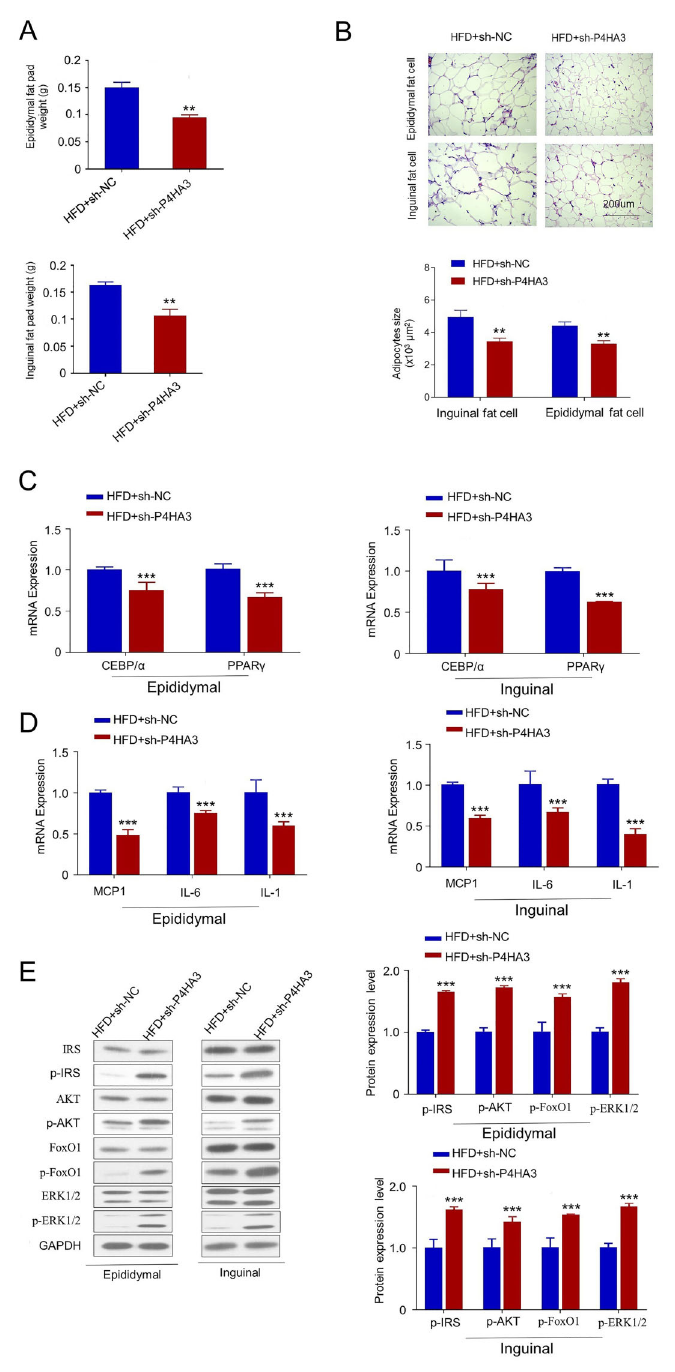
Figure 4. P4HA3 silencing modulated adipocyte differentiation and insulin sensitivity gene expressions in adipose tissue. A , Epididymal and inguinal fat pad weight (g) of db/db mice were measured. B , The cross-sectional area of adipocytes in adipose tissue was analyzed by HE staining (scale bar, 200 m m). C and D , C/EBP- a , PPAR- g , and in fl ammatory factors (MCP1, interleukin (IL)-6, and IL-1) expression in epididymal and inguinal adipose tissues of db/db mice with or without P4HA3 knockdown was quanti fi ed using RT-qPCR. Mice were sacri fi ced after 6-h fasting for tissue collection. E, The phosphorylation levels of FoxO1, IRS, PI3K, and AKT in epididymal and inguinal adipose tissues of db/db mice were analyzed by western blotting. HFD: high fat diet; NC: negative control. Data are reported as means ± SD. **P o 0.01; ***P o 0.001 ( t